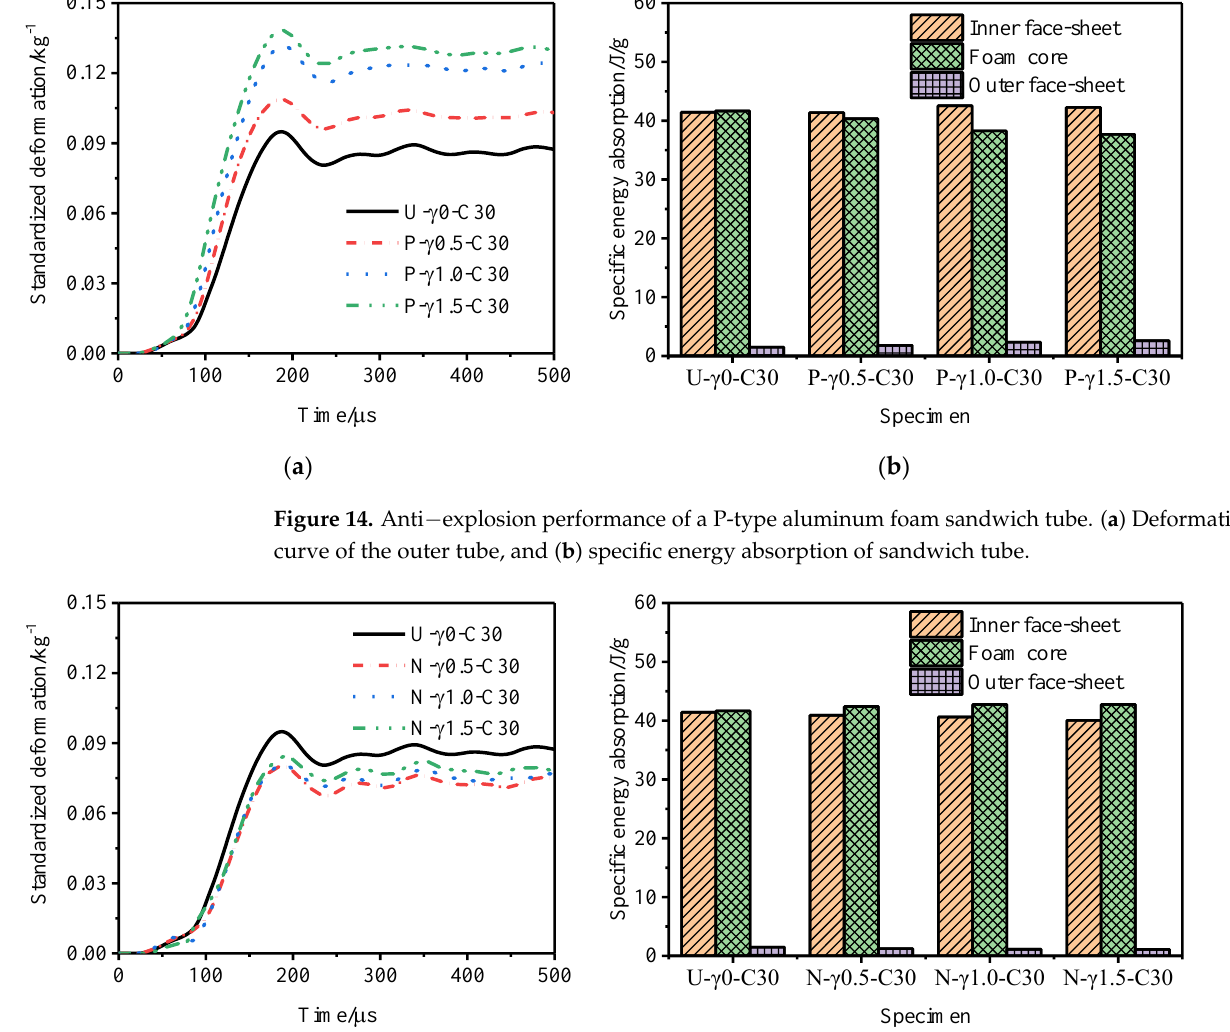
Figure 16. Anti − explosion performance of an MH-type aluminum foam sandwich tube. ( a ) Defor- mation curve of the outer tube and ( b ) specific energy absorbed of sandwich tube.